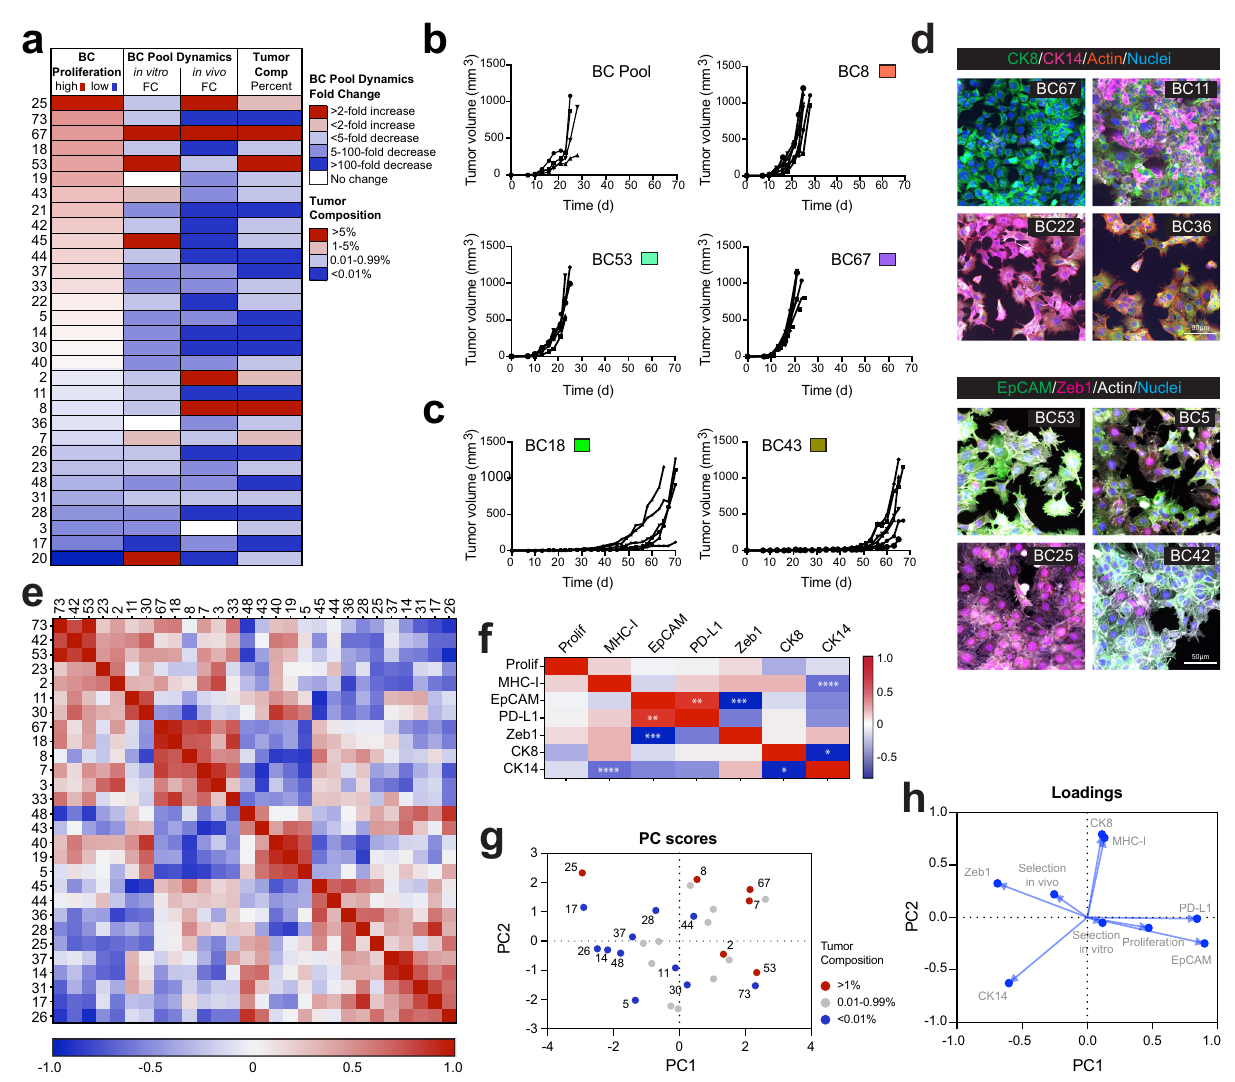
Fig. 4 SunCatcher enables functional and phenotypic analysis of individual clones and clonal dynamics. a Functional analysis of Met1 BCs in monoculture and within the BC Pool. Column 1: proliferation rate (doubling time) of each BC over 9 days in culture, ranked from fastest to slowest. Each row represents data for the BC indicated in column 1. Column 2: Met1 BC Pool clonal dynamics in vitro, represented as fold-change (FC) in BC composition after 7 days (d) relative to initial admixture (data values shown in Table 1). Column 3: Met1 tumor clonal dynamics in vivo, represented as fold-change in BC composition at experimental endpoint relative to composition at time of injection (data values shown in Table 1). Column 4: average contribution of each BC as a percent of total BCs in each resulting tumor ( n = 10). b Growth of Met1 BC Pool tumors ( n = 4) and indicated individual BCs tumors ( n = 6 per cohort). c Growth of indicated BC tumors ( n = 6 per cohort). d Immuno fl uorescence images of indicated BCs stained for cytokeratin 8 (CK8, green), cytokeratin 14 (CK14, magenta), f-actin (red) (top), and epithelial cell adhesion molecule (EpCAM, green), zinc fi nger E-box-binding homeobox 1 (Zeb1) transcription factor (magenta), f-actin (white) (bottom). Nuclei were counterstained with DAPI (blue); Scale bars = 50 μ m. Images represent 1 of 4 images per BC from 2 independent observations. e Pearson correlation matrix for individual Met1 BCs analyzed for: proliferation rate, CK8, CK14, Zeb1, EpCAM,